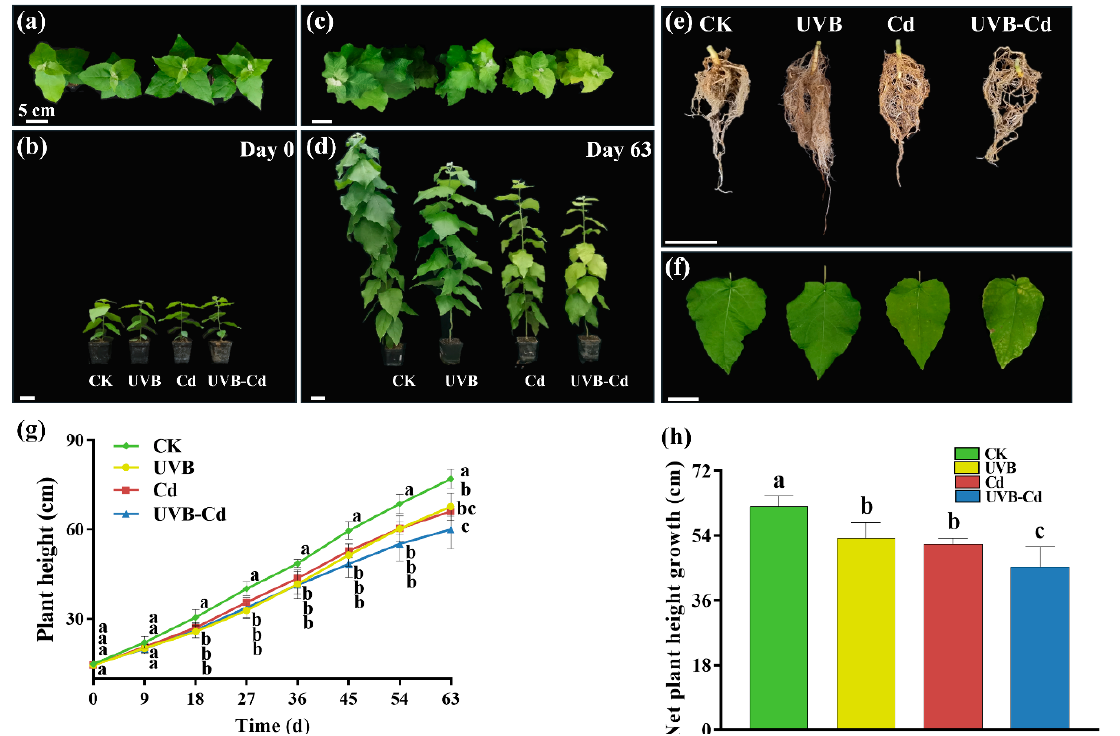
Figure 1. Phenotypic differences of the poplar before and after treatment. ( a – d ) T of the whole plant. ( e ) Root and ( f ) leaf phenotypes of poplar after treatment. ( g ) Plant height. ( h ) Net plant height growth ( n = 9 plants for each treatment). Different letters represent significant differences among four treatment groups ( p < 0.05).